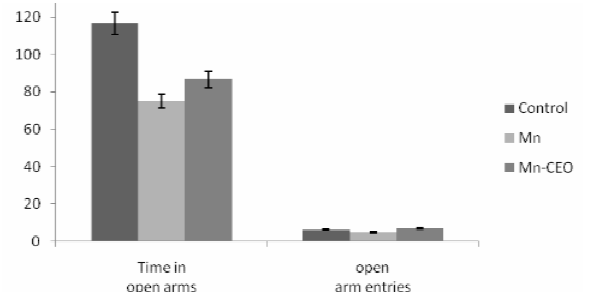
Fig.1. Effect of Mn exposure and clove essential oil during pregnancy and lactation period on anxiety behaviour (plus maze test). Data are mean ± S.E.M. * p<0.05; (Mn vs. Control) p<0.05; (Mn vs Mn-CEO) p<0.05